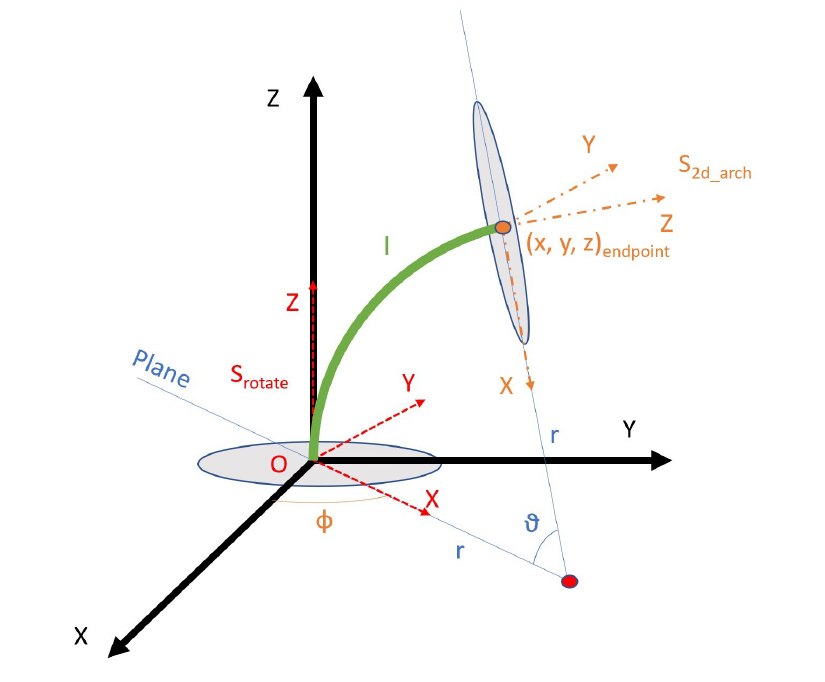
Figure 8. Schematic drawing for direct kinematics